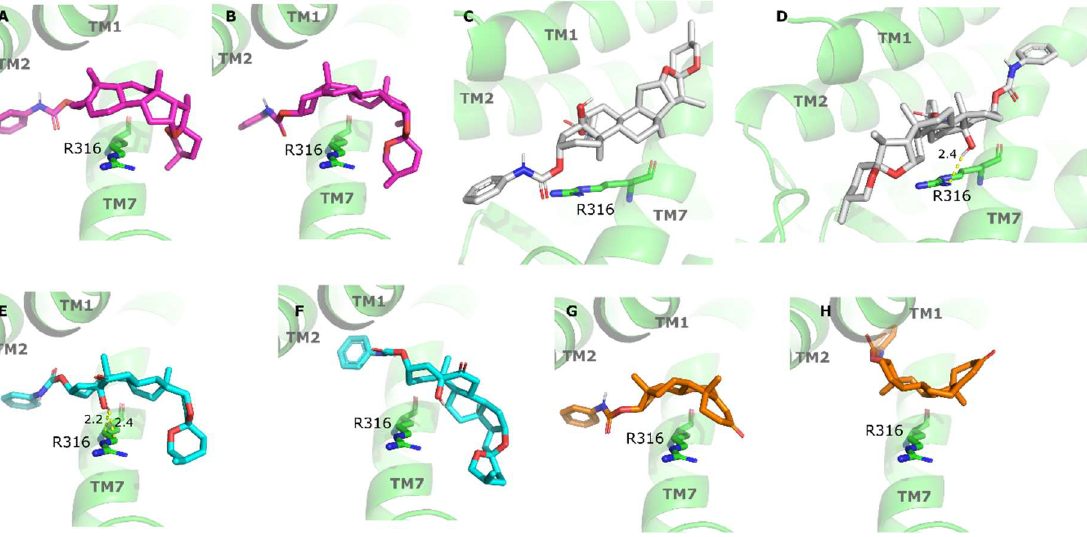
Figure 6. Binding modes of ( A ) 4 (1), ( B ) 4 (2), ( C ) 5 (1), ( D ) 5 (2), ( E ) 6 (1), ( F ) 6 (2), ( G ) 7 (1), and ( H ) 7 (3) within the active site of EP4. EP4 is displayed similar to a green cartoon and R316 residue is shown as green sticks. All distances are given in Å.